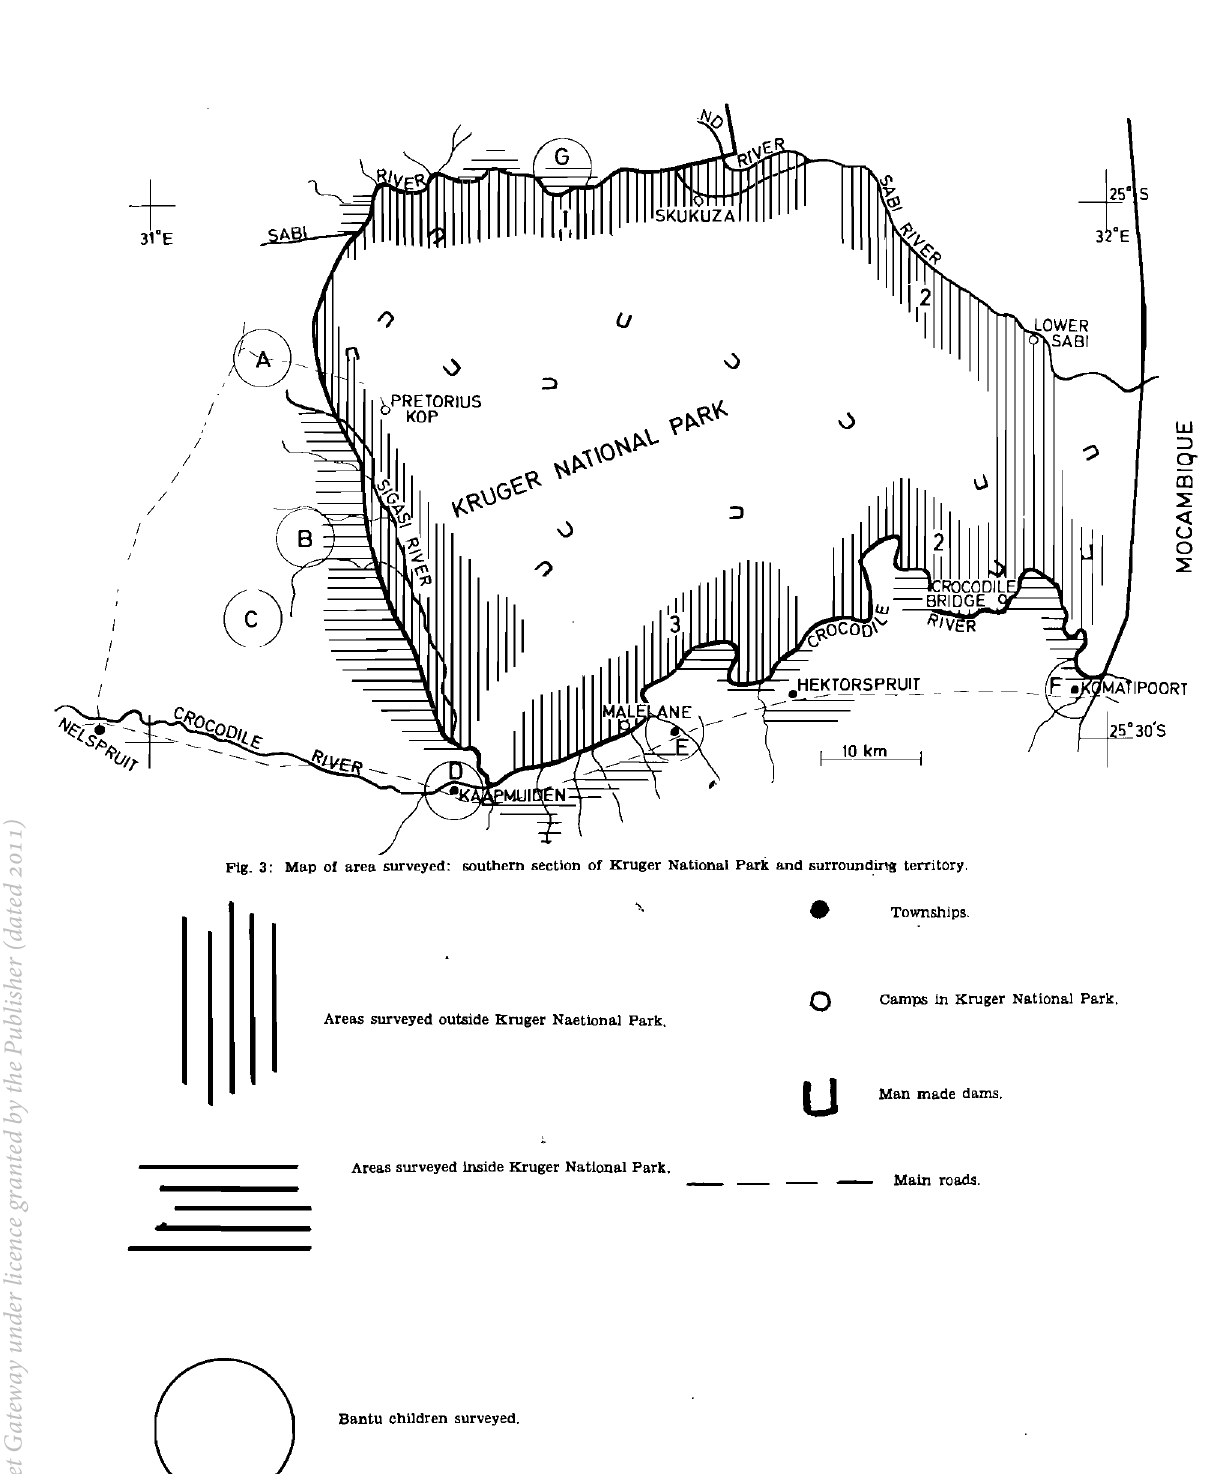
Areas surveyed outside Kruger N aetional Park.